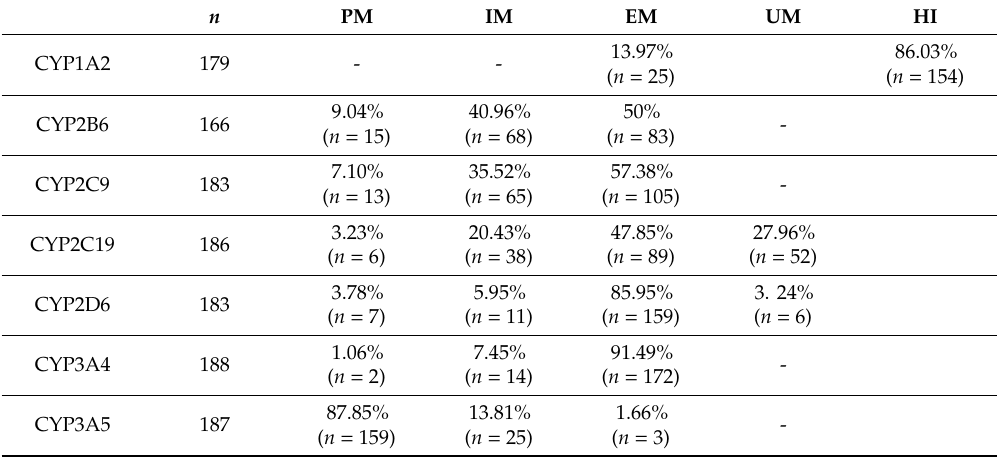
Table 6. Phenotype